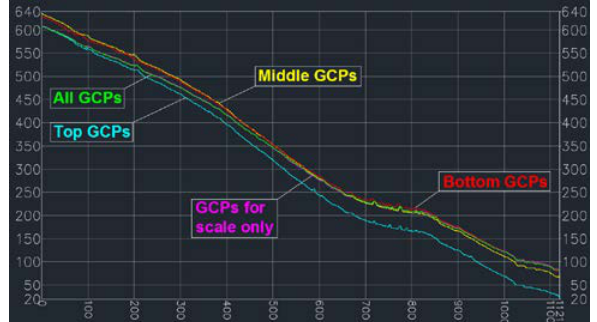
Figure 12. DSM section comparison along rockfall path (units in